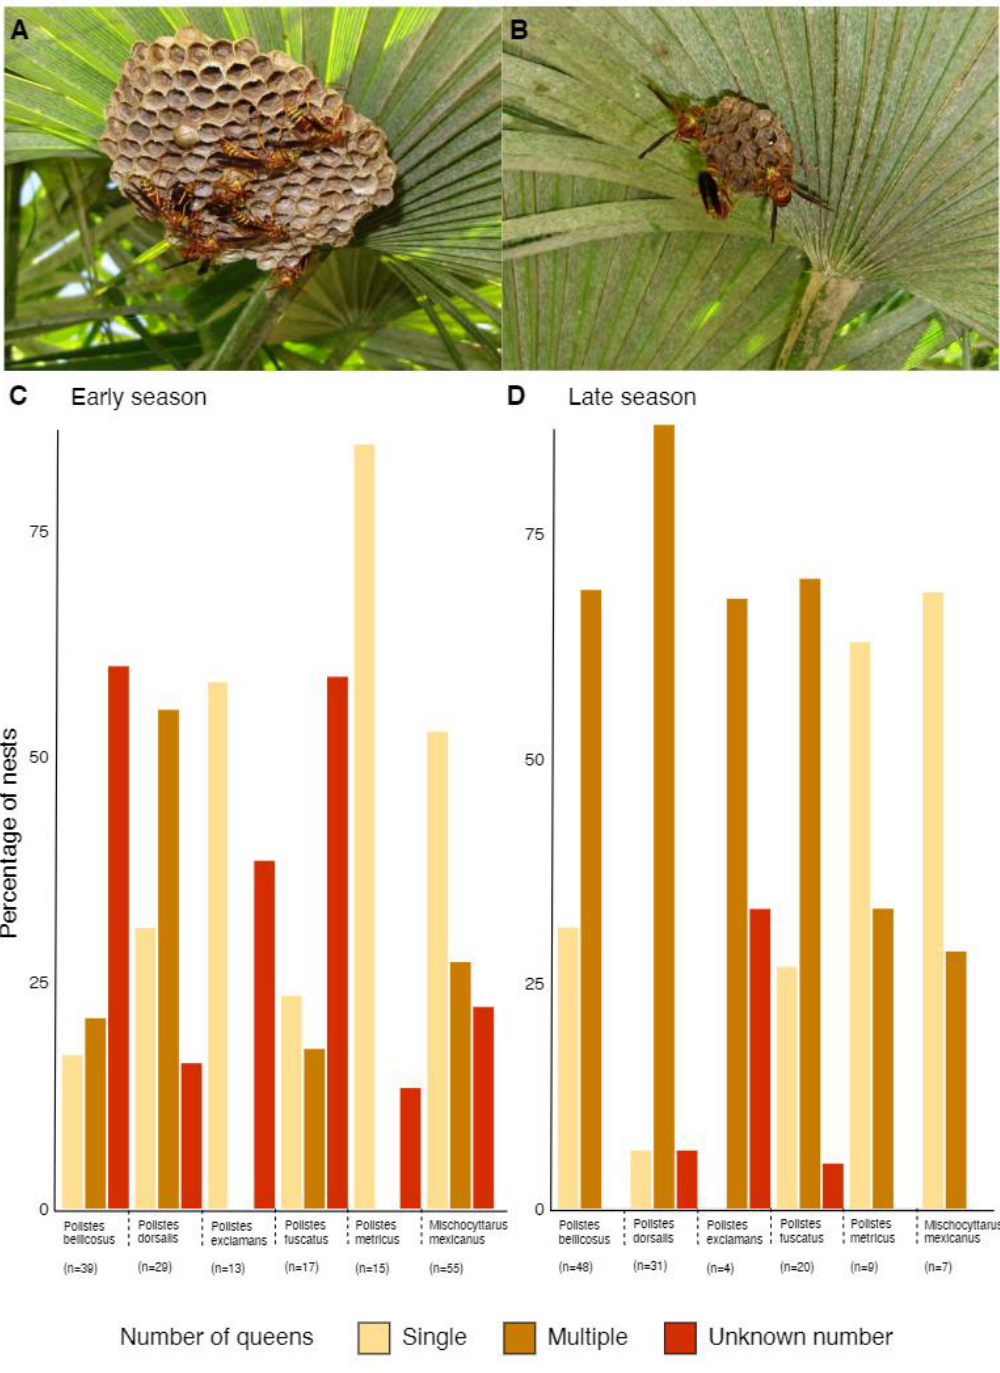
Figure 5. An early season nest of P. bellicosus on 16 August which had naturally declined ( A ) and an associated late season nest of P. bellicosus on 28 August ( B ). Female transfer was noted between the two nests. Percentage of single-foundress, multi-foundress and unknown number of foundress nests for each species in early ( C ) and late season ( D ).